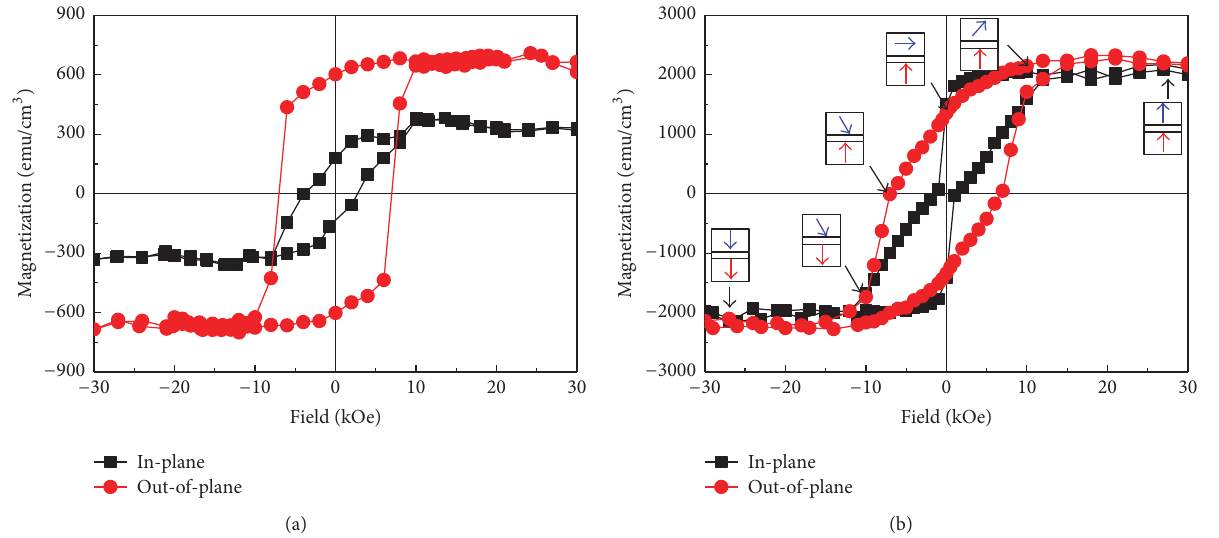
Figure 3: In-plane and out-of-plane magnetic hysteresis loops. (a) The Pt(4)/L1 0 -FePt(15) bilayers. (b) The Pt(4)/L1 0 -FePt(15)/ZnO(5)/ Fe(5)/Pt(3) multilayers. The arrows show the magnetization reversal process of the Fe free layer (top blue) and FePt reference layer (bottom red) in the out-of-plane loop in